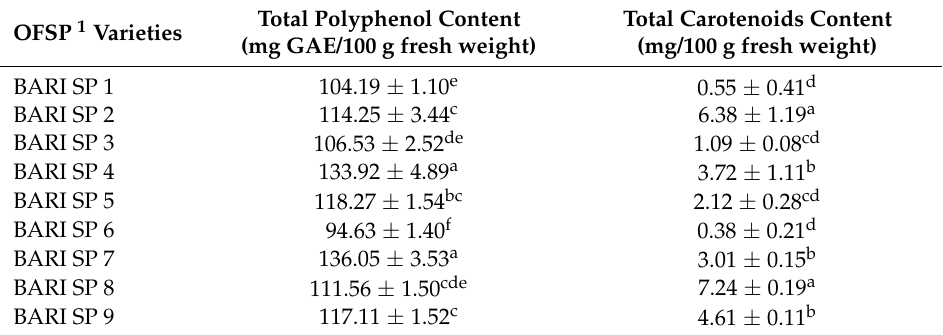
Table 3. Total polyphenol content and total carotenoids content of selected varieties of orange-fleshed sweet potato with